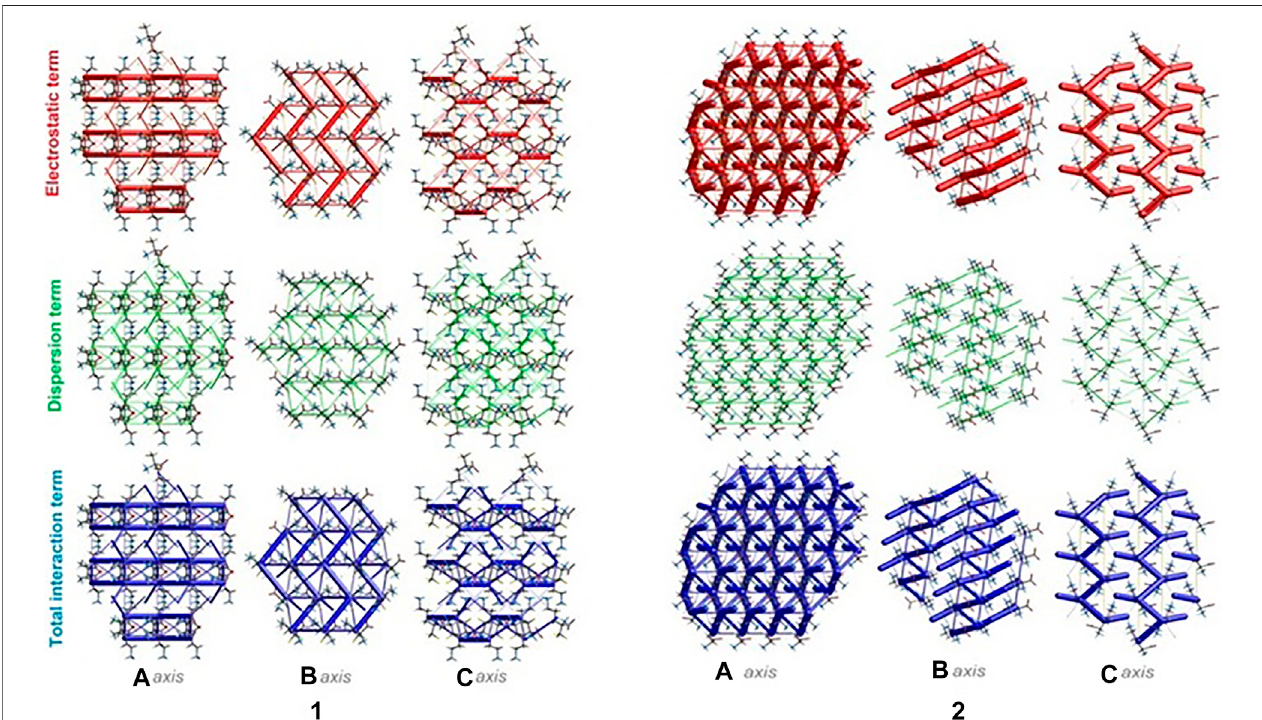
FIGURE6| Energy frameworks ofcrystals 1 and 2 correspondingtotheelectrostaticand dispersion energy components,andthetotal energy framework along a, b and c -axis. The cylinders thickness shows the relative strength of molecular packing.